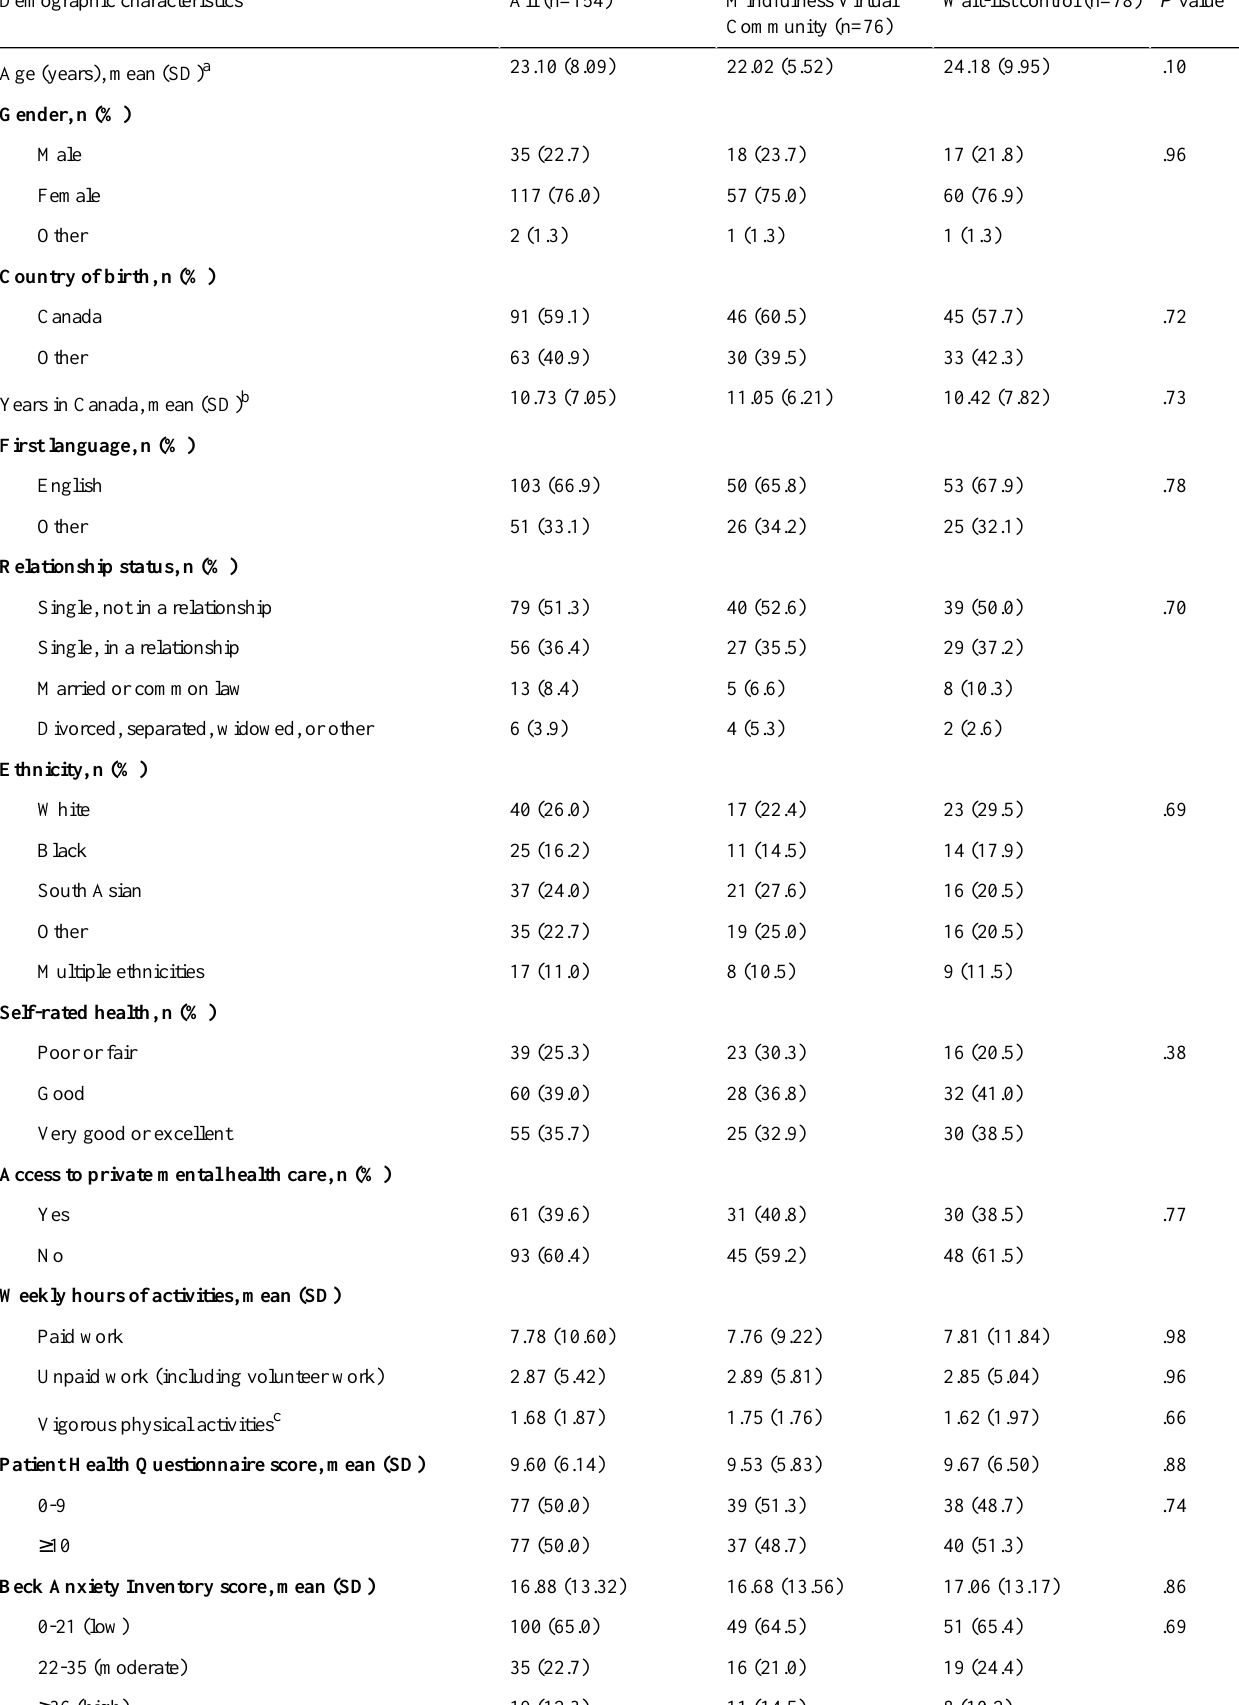
P valueWait-list control (n=78)Mindfulness